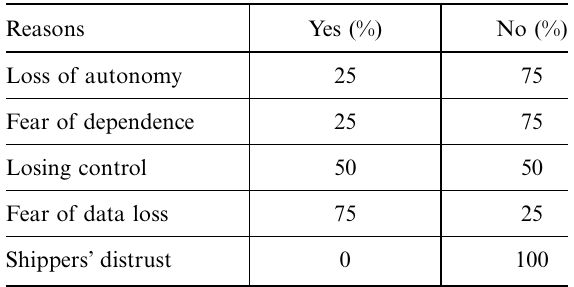
Table 2. Factors of unsatisfactory relationships Reasons